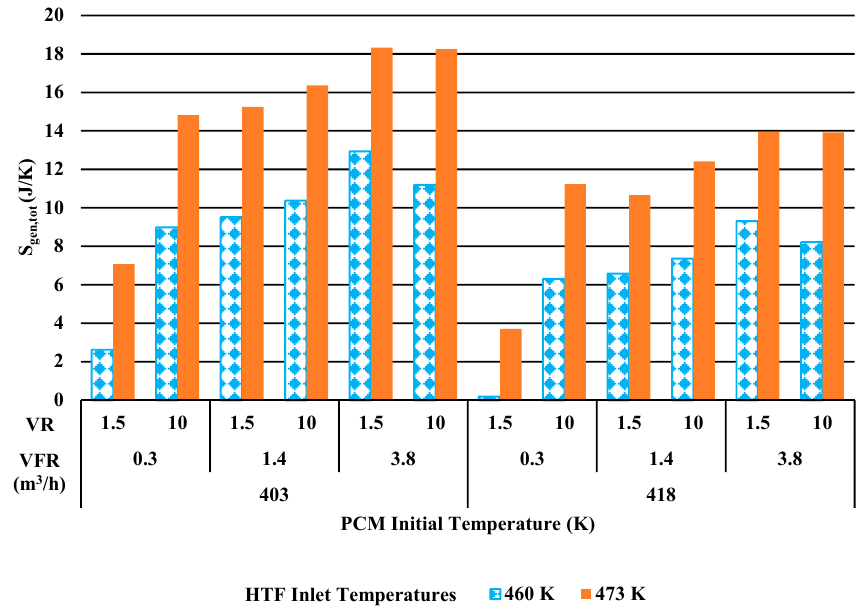
Figure 10. Entropy generation variation in terms of HTF inlet temperature.